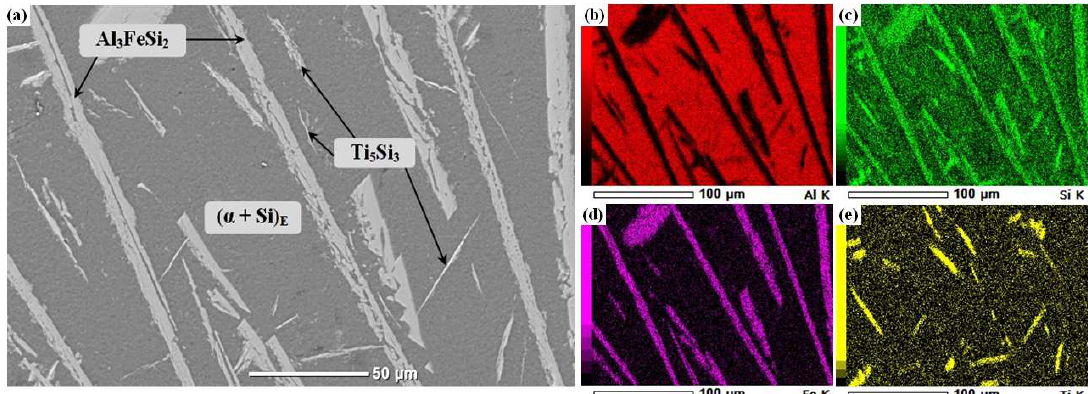
Figure 8. ( a ) Backscattered electron image of AlSiFe with 1 wt. % Ti alloy. Elemental mapping of ( b ) aluminum, ( c ) silicon, ( d ) iron, and ( e ) titanium. (α+Si) E = Eutectic.